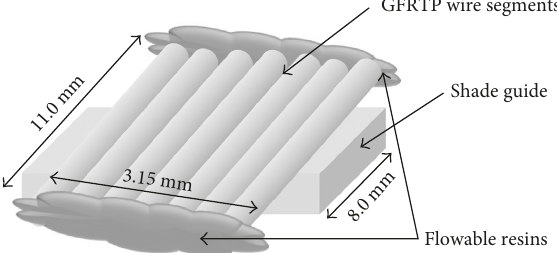
Figure 2: Illustration of the GFRTP sample devised for colori- metric